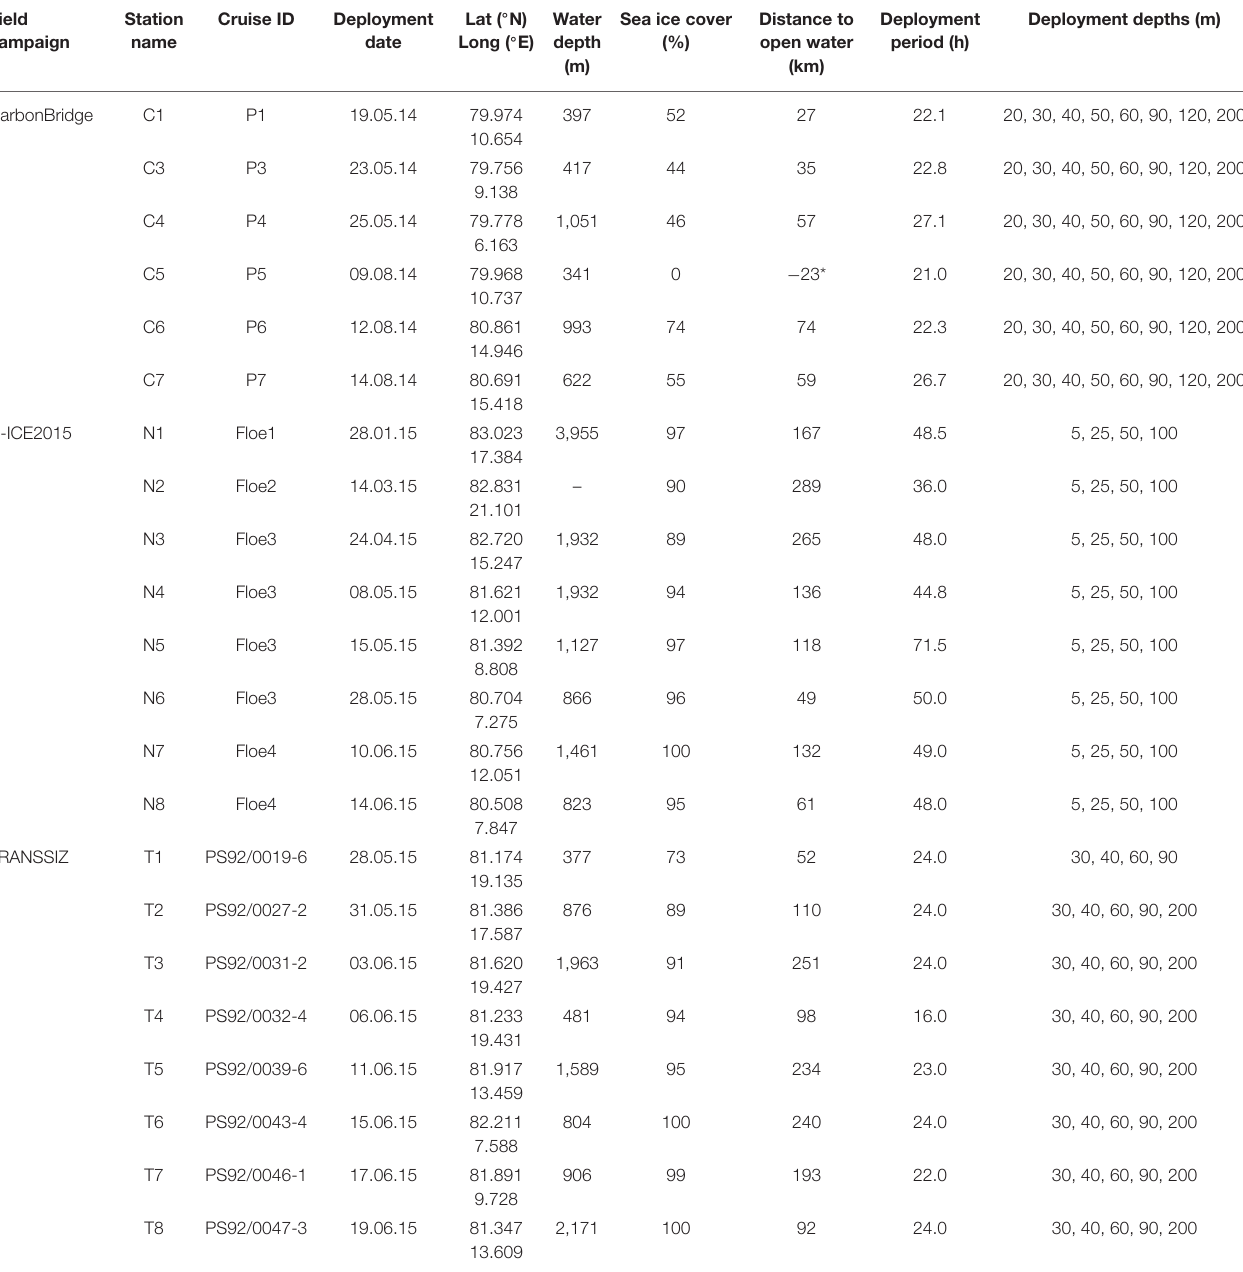
TABLE 1 | Sampling station, cruise ID, sediment trap deployment date, location, water depth, sea ice cover, distance to open water, deployment period, and deployment